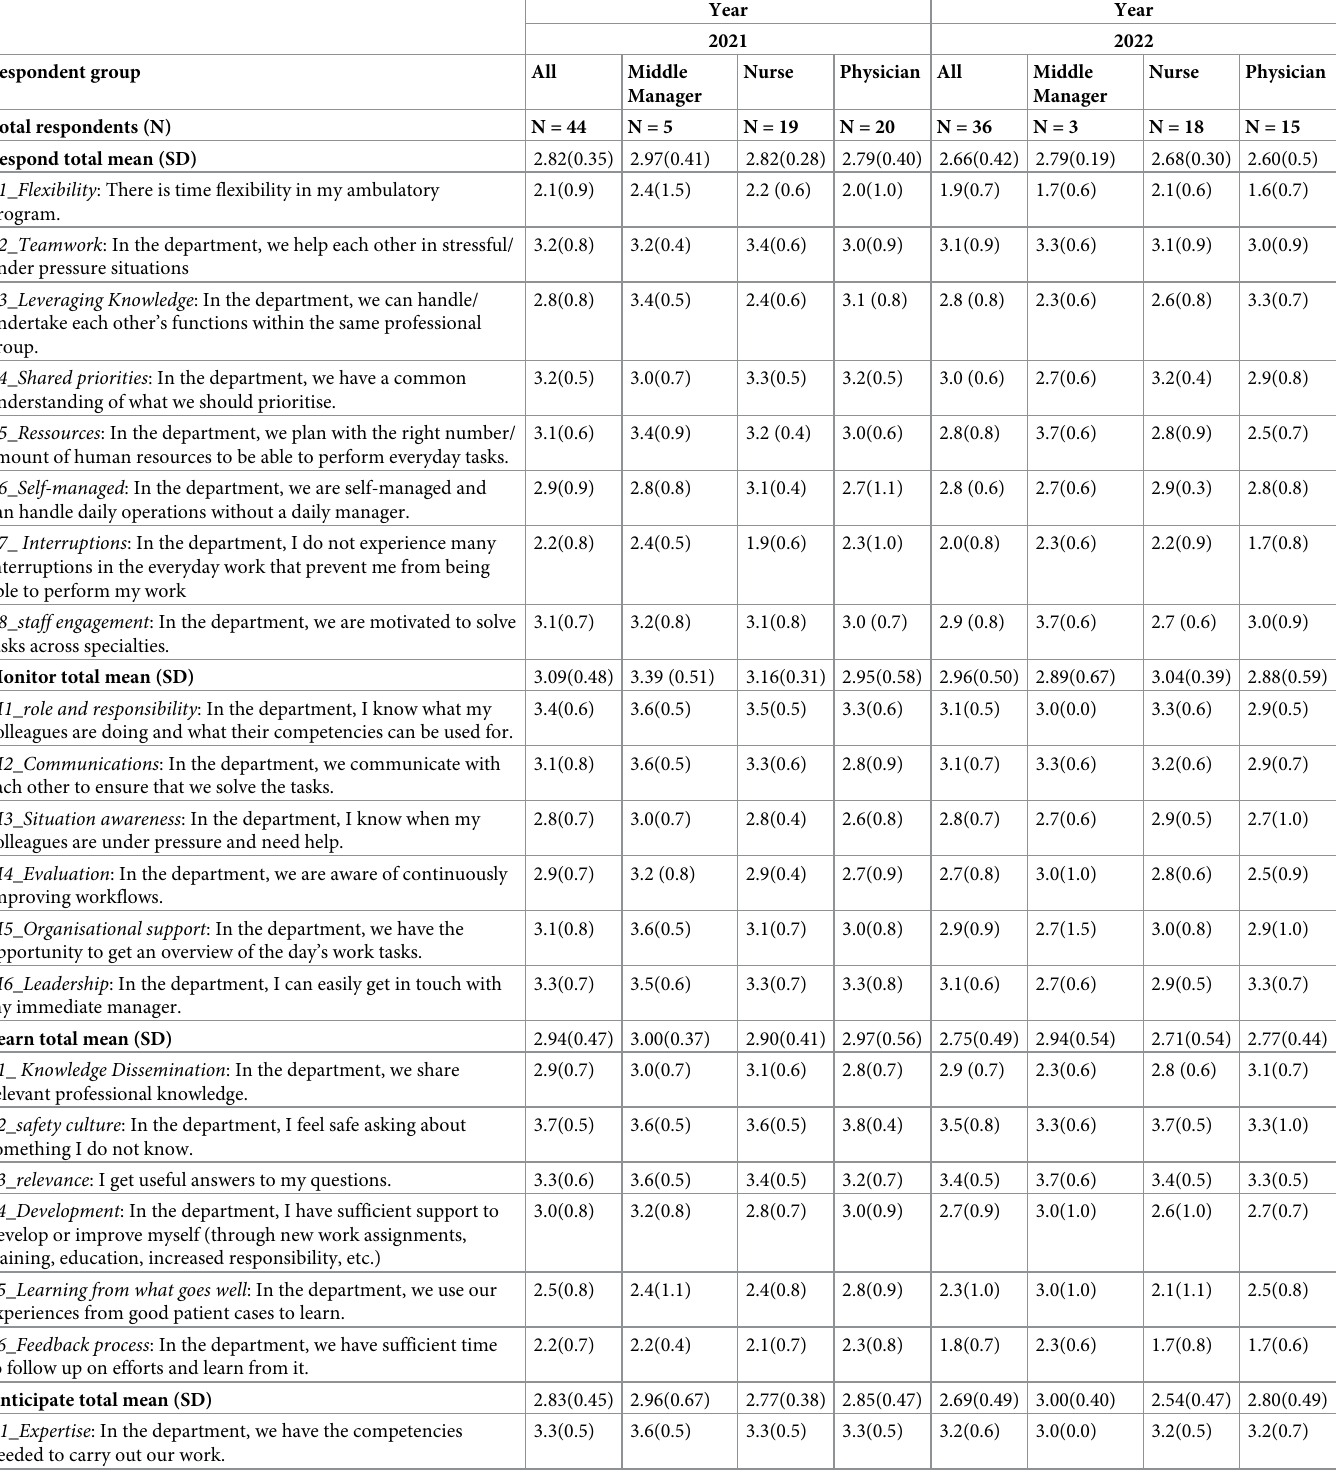
Table 2. Overview of the mean scores for each item in 2021 and 2022 and stratified by respondent